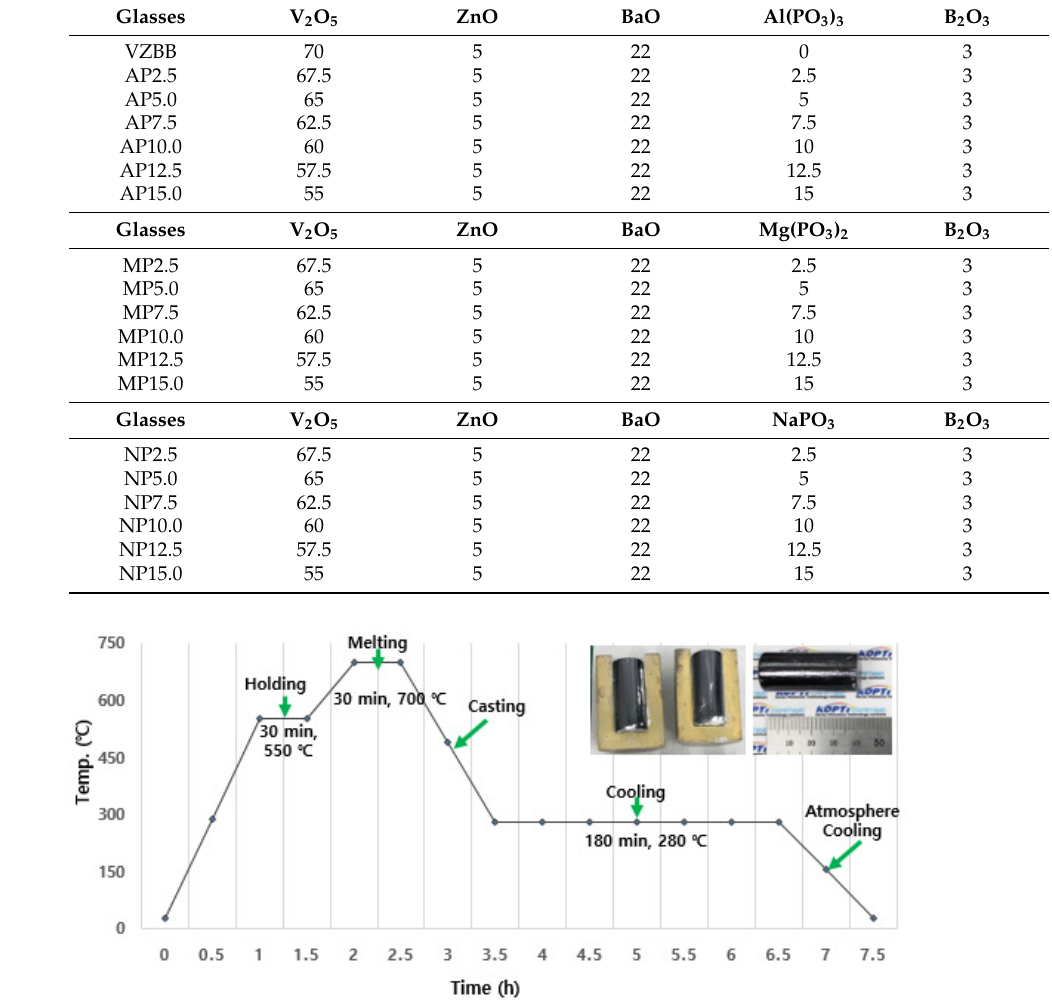
Figure 1. Thermal profile of (70-x)V 2 O 5 -5ZnO-22BaO-3B 2 O 3 -xM(PO 3 ) n glass system (mol%) (where M = Al, Mg, Na, n = 3, 2, 1, respectively, mol%), and inset depicts photographs of glass samples.